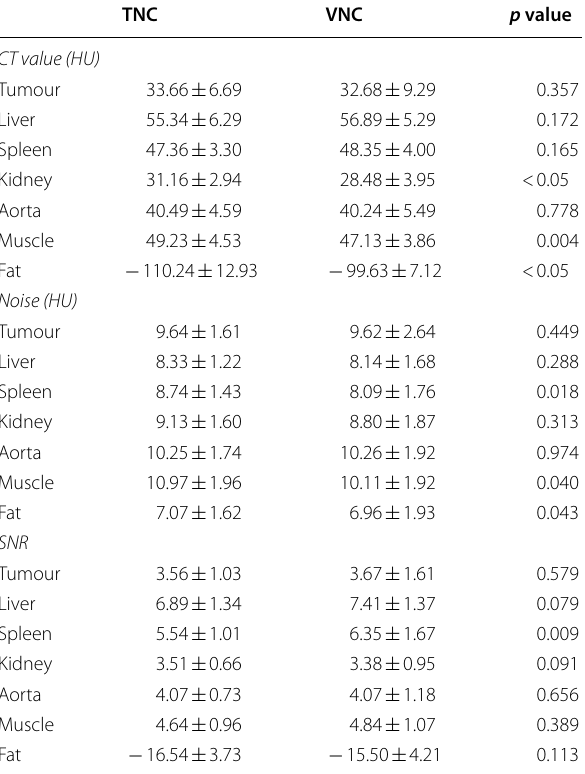
Table 1 CT values, noise and SNR of different organs and tissues in the TNC and VNC images